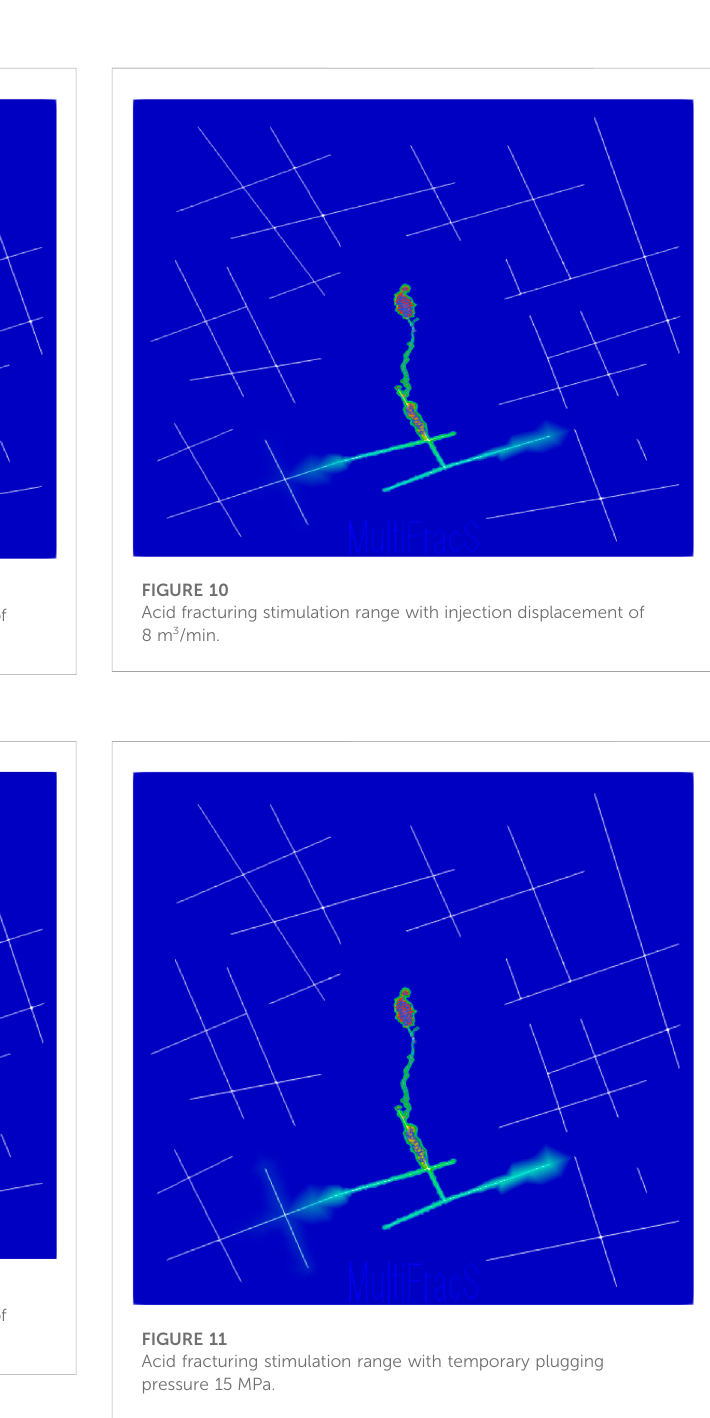
FIGURE 9 Acid fracturing stimulation range with injection displacement of 6 m 3 /min.